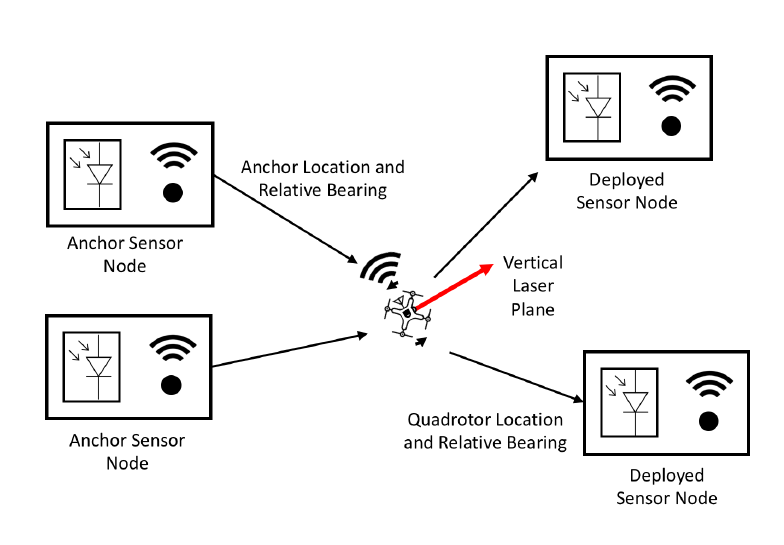
Figure 1. Schematic of proposed distributed lighthouse self-localization. The quadrotor can act as a lighthouse base station by rotating in order to obtain relative bearings between itself and wireless sensor nodes with known locations, or anchor sensor nodes . In this system, the quadrotor can localize itself based on bearing measurements relative to these anchor sensor nodes. The quadrotor can also provide relative bearing measurements to recently deployed sensor nodes with unknown locations ( deployed sensor nodes ), which allows them to localize